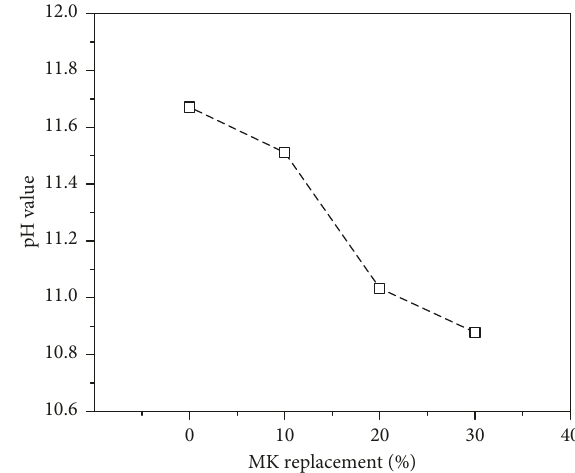
Figure 4: pH values of treated JX clay mixtures cured for